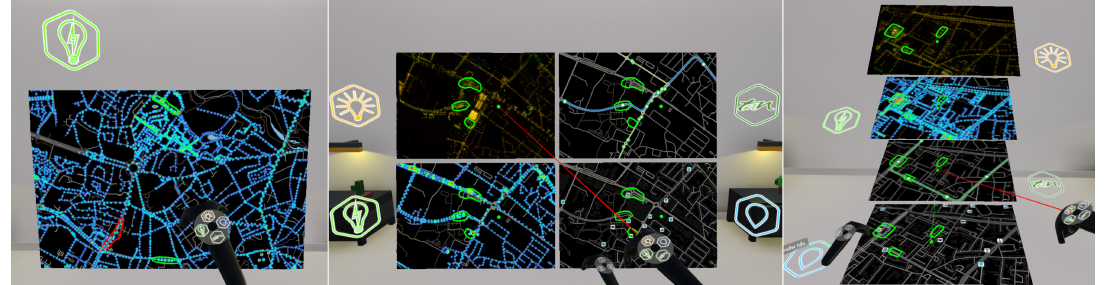
Figure 1. ( Left ): Temporal multiplexing (blitting); center and right: spatial multiplexing—in a grid ( center ), and in our proposed stack ( right ). Shown as implemented for the user study, with controller